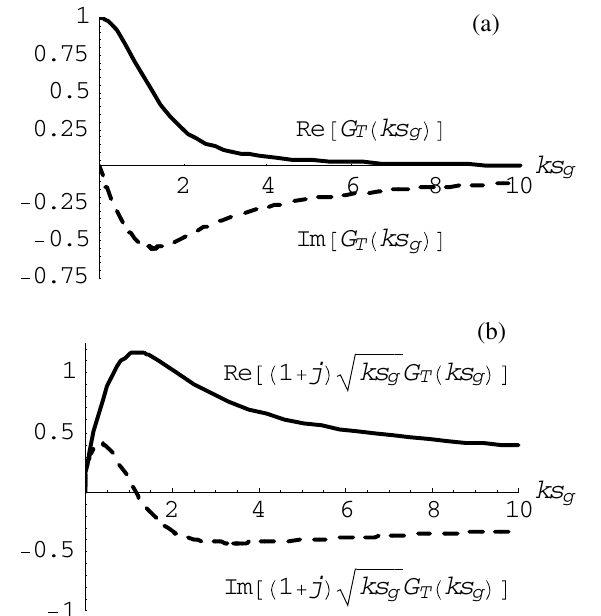
FIG. 2. (a) The real (solid curve) and imaginary (dashed from Eq. (1.5). (b) The real curve) parts of the function G T (solid curve) and imaginary (dashed curve) parts of (cid:1) 1 (cid:8) j (cid:3) (cid:12) p G (cid:1)(cid:1)(cid:1)(cid:1)(cid:1)(cid:1)(cid:1) ks (cid:1) ks (cid:3) , which gives the frequency dependence of g T g